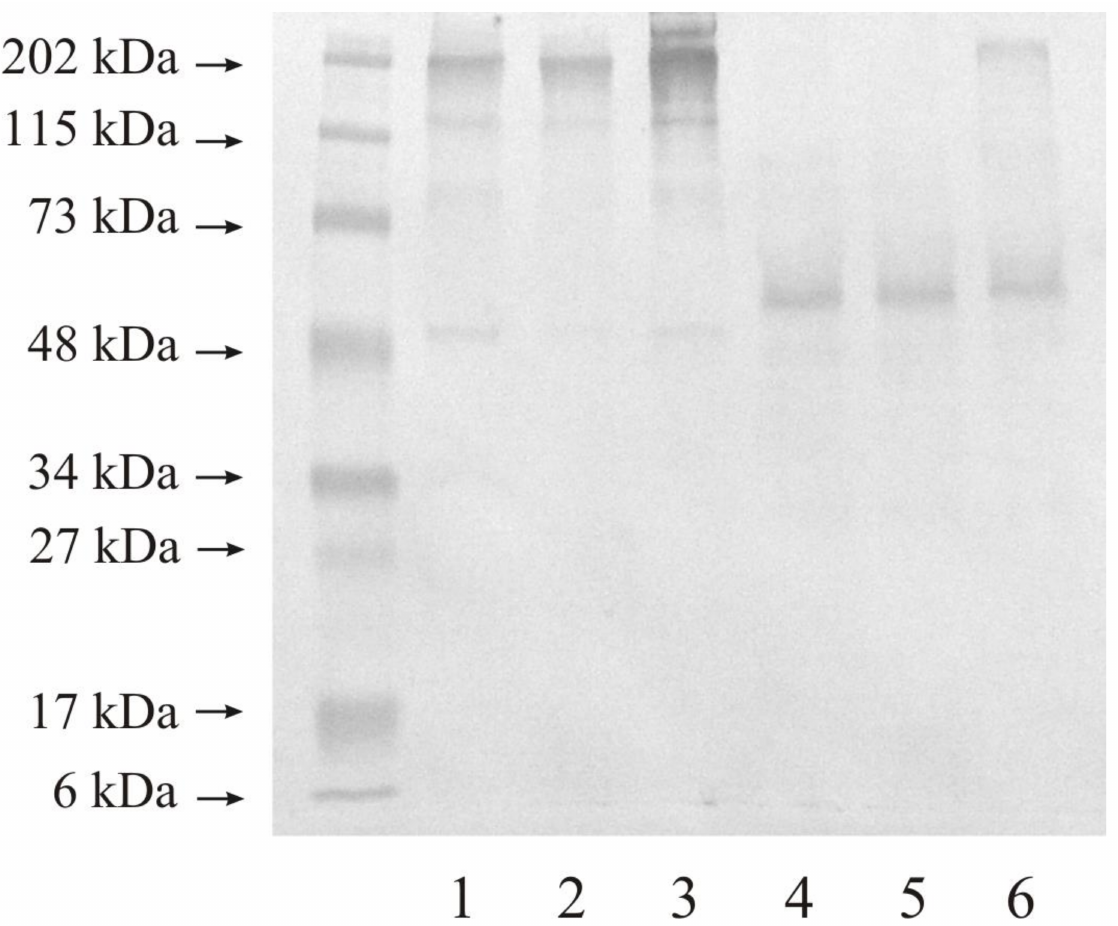
Figure 4. Western immunoblot of MMP-10 in control tissue and low-grade (LG) and high-grade (HG) urinary bladder cancer. Twenty micrograms of protein: lane 1—control urinary bladder, 2—low-grade bladder cancer, 3—high-grade bladder